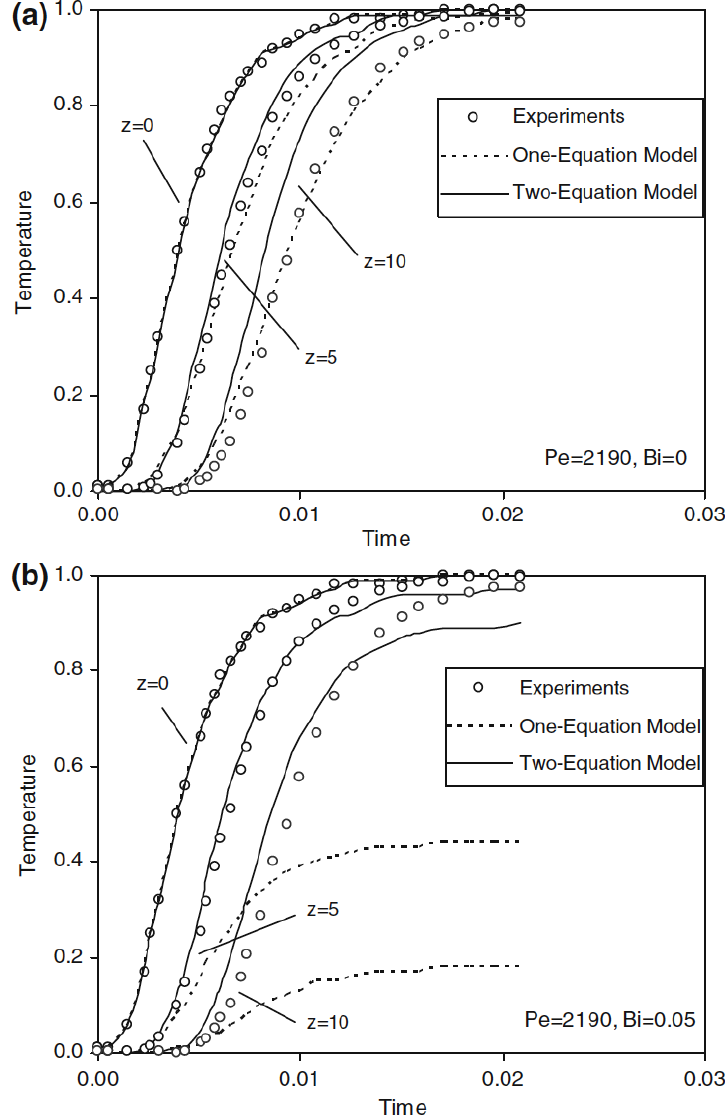
Figure 20. Local temperature profiles from experiments compared with numerical results from one-equation and two-equation models, for steel-water bed at ( a ) Bi = 0, and ( b ) Bi = 0.05, reported by Singh et al.